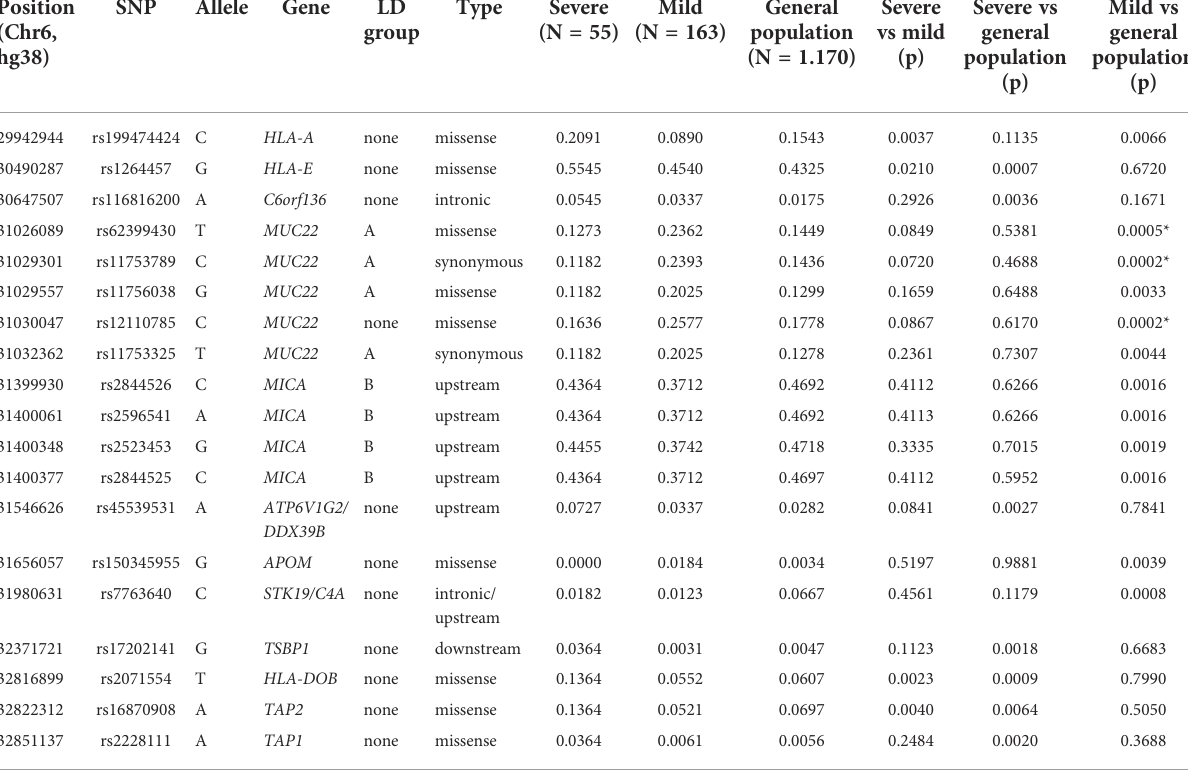
TABLE 1 Polymorphisms across the MHC region (SNPs and indels) that are associated with Covid-19 severity in Brazilian patients. Position (Chr6,